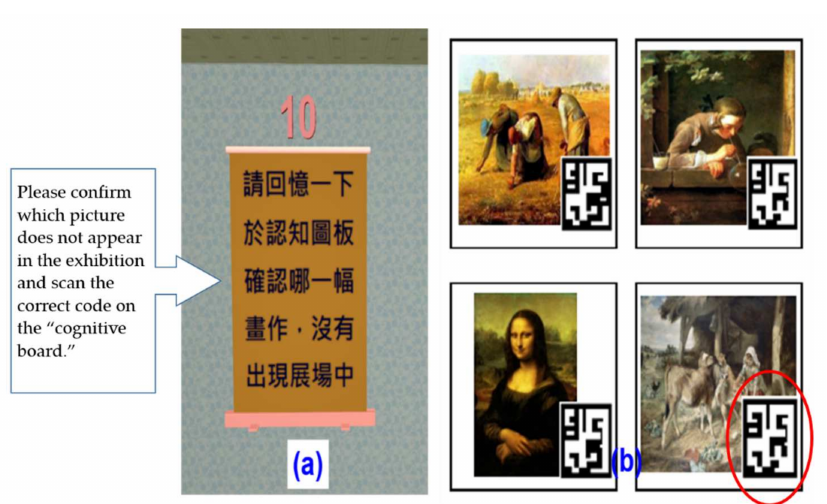
Figure 11. Episodic memory test screen: ( a ) Instructions screen for confirming which picture does not appear in the exhibition; ( b ) Confirm and scan the correct code on the cognitive